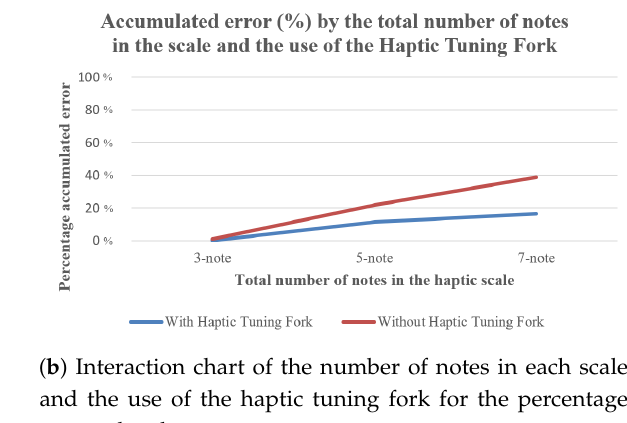
Figure 4. Interaction effect charts for Experiment A.